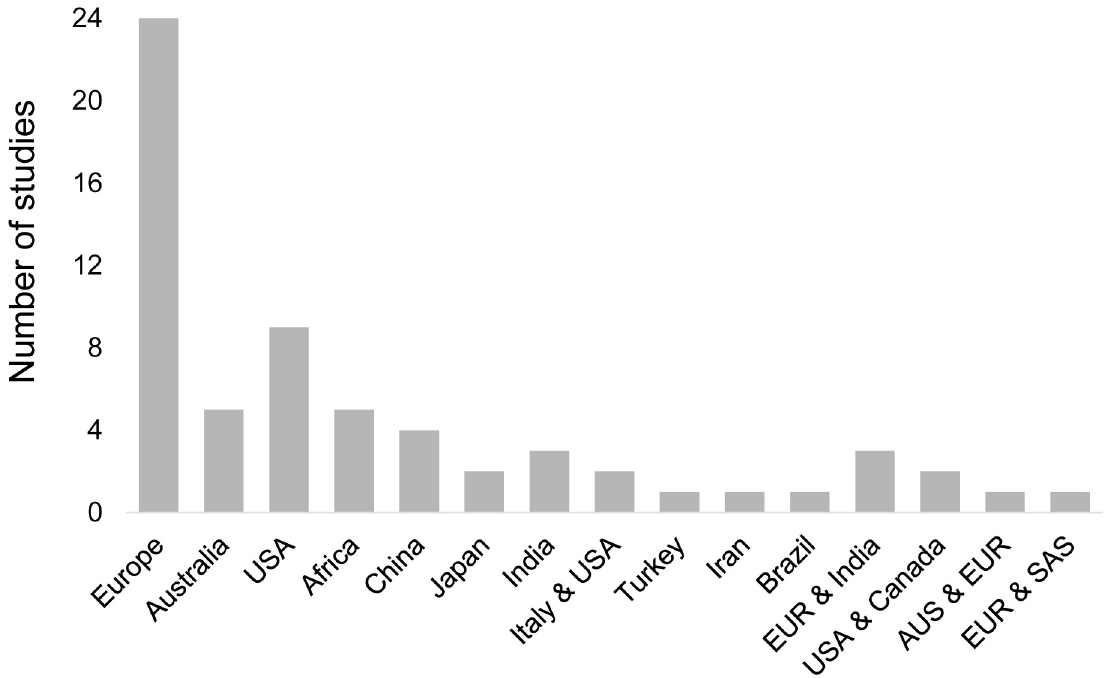
Fig 1. Geographical locations of the sixty-four studies that reported genetic variants associated with iron imbalance. Nine studies involved multi-ethnic populations. AUS, Australia; EUR, Europe; SAS, South Asia.